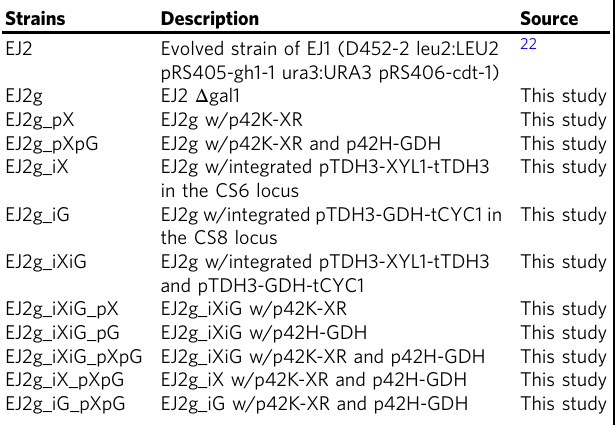
Table 1 Engineered S. cerevisiae strains used in this study Strains